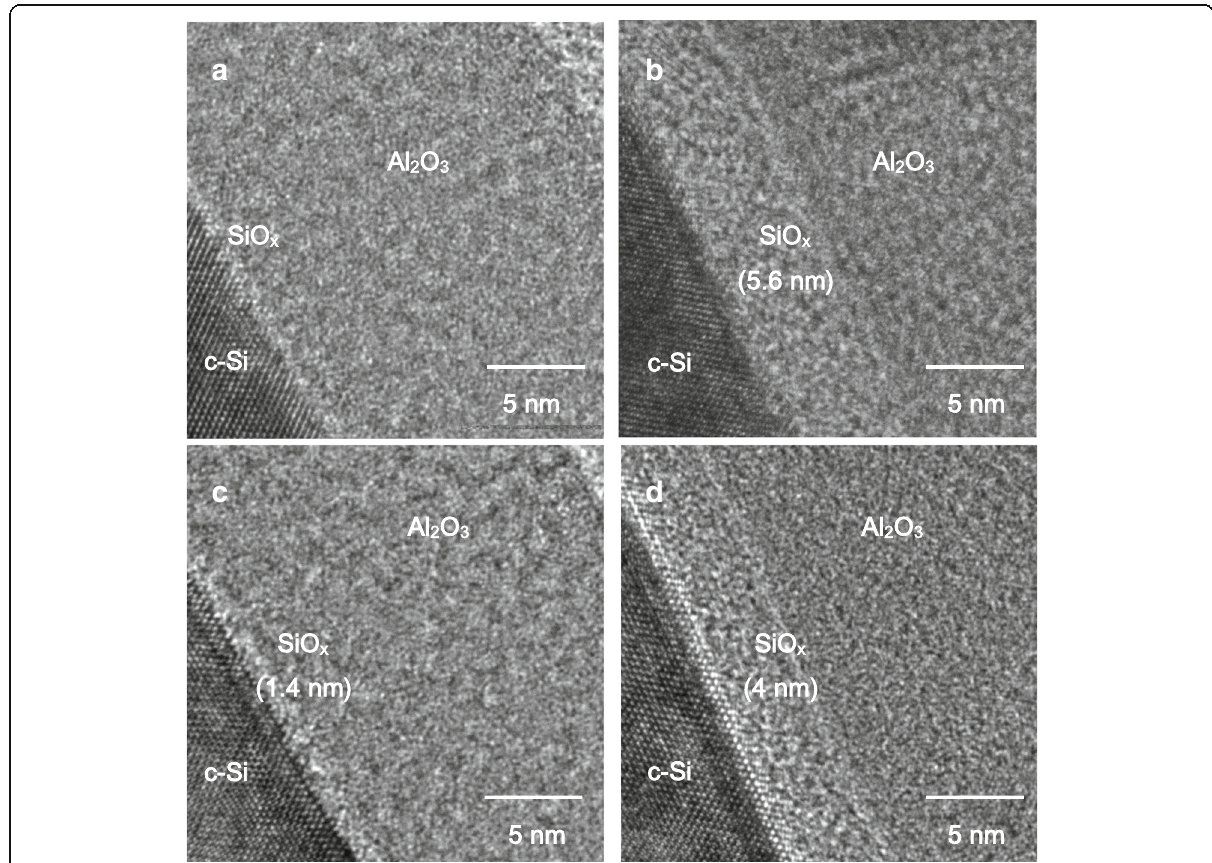
Fig. 4 Cross-sectional TEM images for samples a without annealing and with b O 2 , c FG, and d two-step